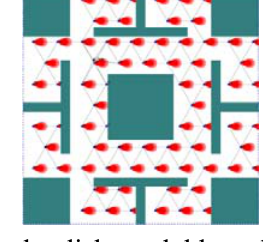
(a) Under the disk model based algorithm (b) Under the Deploy-Random